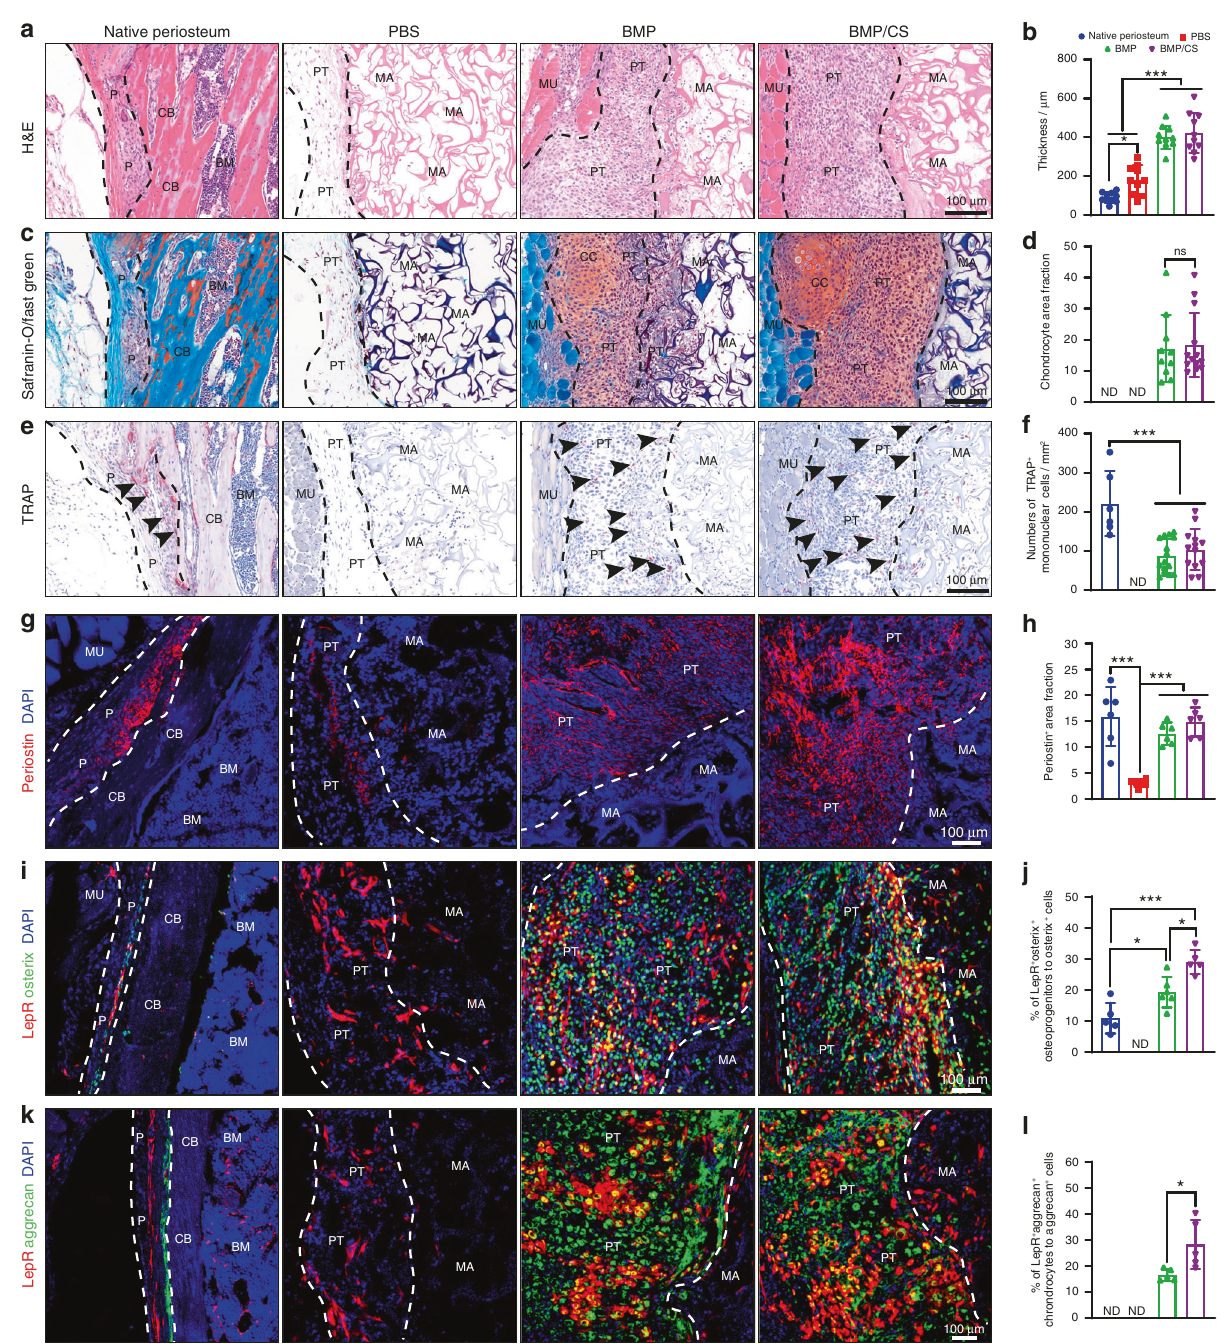
Fig. 1 PTs possess a similar architecture to the native periosteum. a – f Histological staining and quantitative analysis of native femur periosteum and induced tissues from the Lepr -cre; tdTomato mice for H&E ( a , b ), Safranin O/Fast Green ( c , d ), and tartrate-resistant acid phosphatase (TRAP) ( e – f ) staining ( n = 6 – 10) in the PBS, BMP, and BMP/CS groups. g – l Immuno fl uorescence staining and quantitative analysis of periostin (red; g , h ), LepR + cell-derived osteoprogenitors (LepR + Osterix + , yellow; i , j ), and LepR + cell-derived chondrocytes (LepR + Aggrecan + , yellow; k , l ) in the native femur periosteum, PBS, BMP, and BMP/CS groups in the Lepr -cre; tdTomato mice ( n = 5 – 13). Periostin- and LepR-positive cells are red, Osterix- or Aggrecan-positive cells are green, and DAPI is blue (nucleus). Periosteum (P), periosteum- like tissue (PT), cortical bone (CB), chondrocyte (CC), material (MA), muscle (MU), not detected (ND). The black dashed line indicates the native periosteum and induced tissues ( a , c , e ). The black arrowhead indicates TRAP-positive cells ( e ). The white dashed line indicates the border of the periosteum and cortical bone or PT and material ( g , i , k ). Scale bar, 100 μ m. Data are presented as the mean ± SD. * P < 0.05, ** P < 0.01, *** P < 0.001, one-way ANOVA followed by Tukey ’ s post hoc tests or two-tailed Student ’ s t BMP and BMP/CS groups underwent active bone remodeling at transplantation (Fig. 3c, e). The thickness of new bone in the all indicated time points, and the number of TRAP + mono- BMP and BMP/CS groups was higher than that in the PBS group but was not signi fi cantly different between the BMP and BMP/CS nuclear cells was much higher in the BMP and BMP/CS groups groups (Fig. 3d). Moreover, newly generated bone from both the than in the PBS groups (Fig. 3e, f).